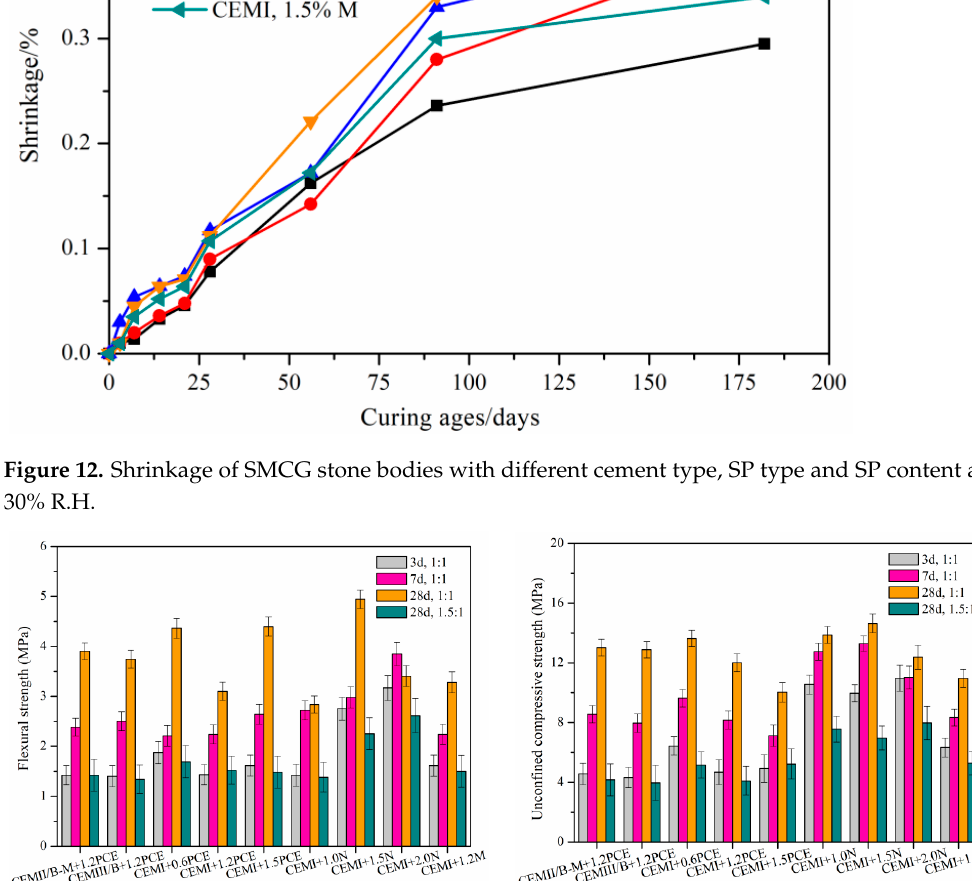
Figure 13. Flexural and unconfined compressive strengths of SMCG with key formulation (cement type, SP type, SP content and W/S). ( a ) Flexural strength; ( b ) Unconfined compressive strength.